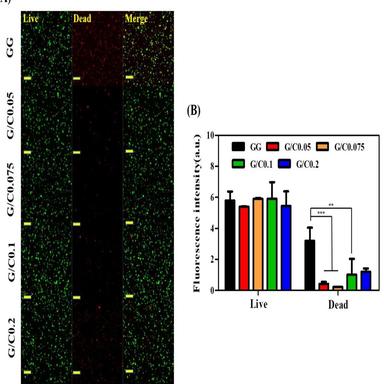
(A) LSM image of chondrocytes encapsulated in the hydrogels analyzed with a Z-stack mode and (B) relative intensity of LSM images (scale bar = 50 μm) (values are mean ± SD, n = 3, P b 0.05 (\), P b 0.01 (\\), P b 0.001 (\\\)).